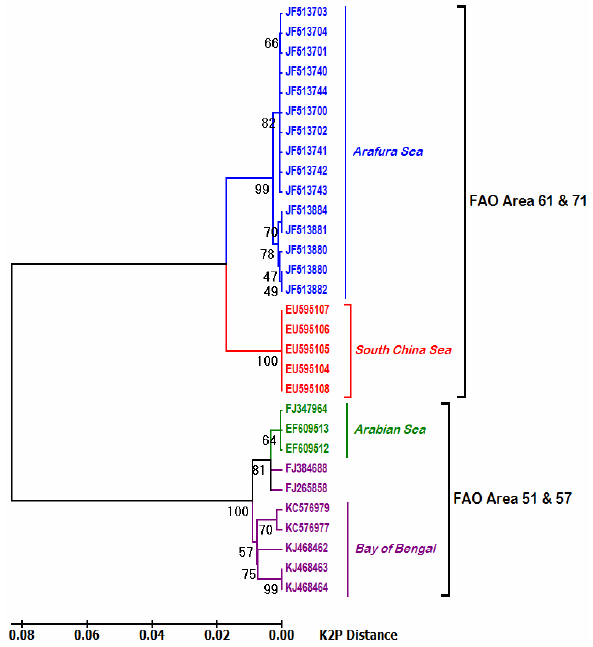
Fig. 2. NJ tree according to haplotypes from four FAO fishing area of E. tetradactylum based on COI gene Table 2. Genetic diversity of E. tetradactylum populations based on COI sequence Population